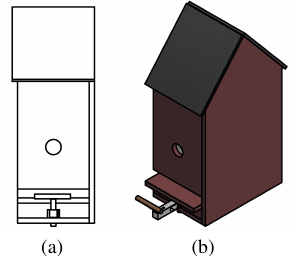
Table 2. List of all casing components needed to operate the feeder, including the costs.